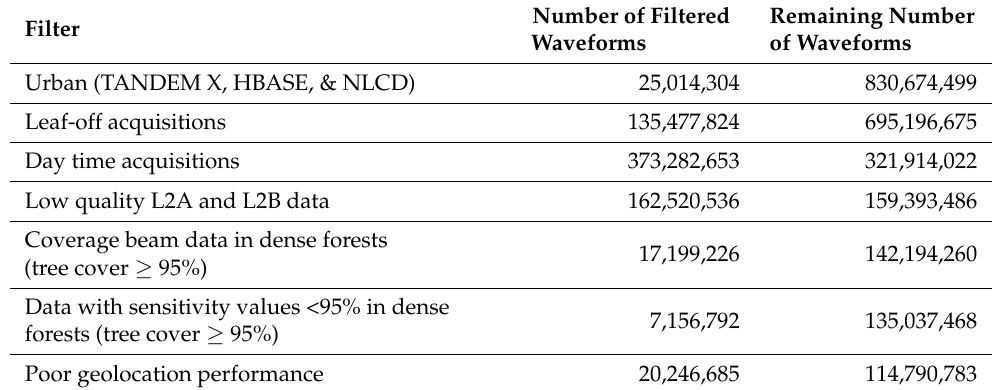
Table 3. Remaining number of GEDI waveforms and the number of filtered waveforms.